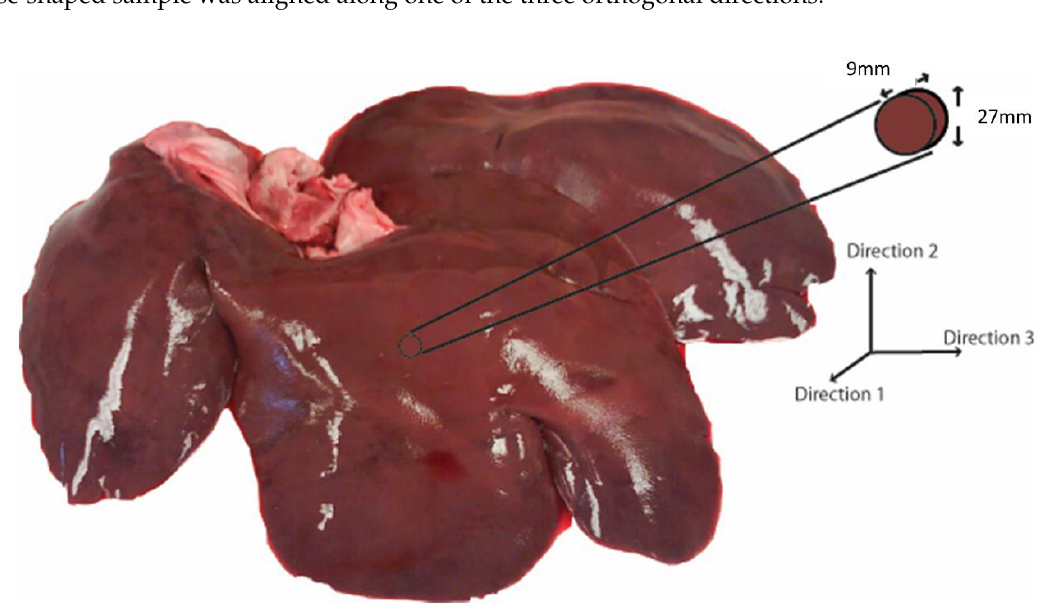
Figure 1. Three orthogonal directions (1, 2, and 3) based on porcine liver anatomy. Representative sample geometry and size.